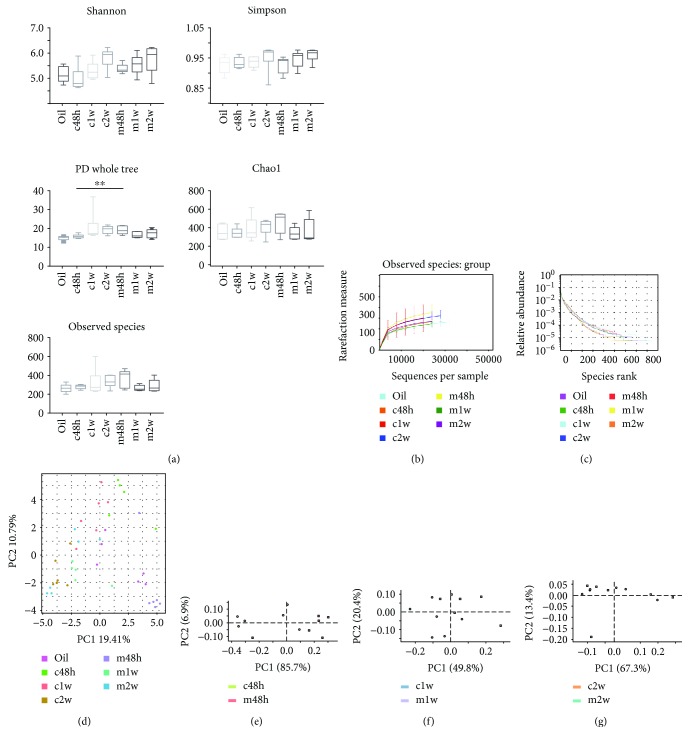
Comparison of the intestinal microbiota structure between the carbon tetrachloride- (CCl4-) treated and mesenchymal stem cell- (MSC-) transplanted groups. The cecum and colon contents were collected from C57BL/6 mice at 48 h, 1 w, and 2 w after performing CCl4 administration. (a) Alpha diversity measures (Shannon and Simpson indices), phylogenetic diversity whole-tree index, and richness indices (Chao1 and observed species). n = 6 per group; mean ± standard deviation (SD); t-test (∗∗
p < 0.01 vs. CCl4). (b) Rarefaction curves. (c) Rank abundance curves. (d) Principal coordinates analysis plot based on the UniFrac distance. Principal component analysis at 48 h (e), 1 w (f), and 2 w (g) using STAMP software. Oil: olive oil control; c: CCl4-treated group; m: MSC-transplanted group. 48 h, 1 w, and 2 w indicate 48 hours, 1 week, and 2 weeks after CCl4 treatment, respectively.